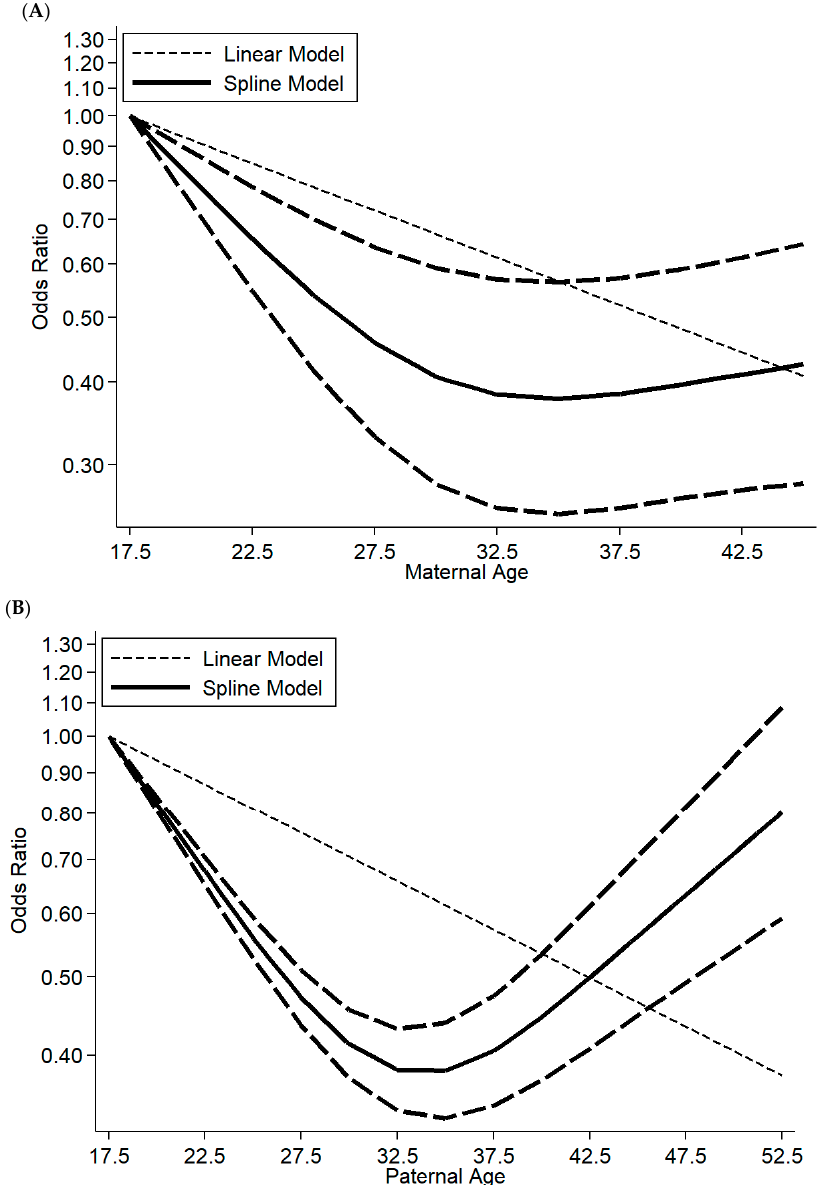
Figure 4. Dose–response association between ( A ) maternal age and offspring ADHD risk; ( B ) paternal age and offspring ADHD risk. Solid lines represent a relative risk; dashed lines represent 95% confidence intervals.